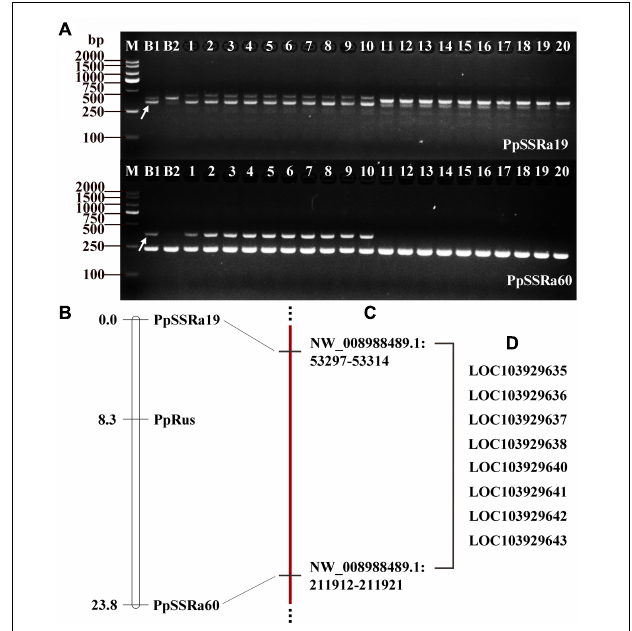
FIGURE 3 | Simple sequence repeat (SSR) markers and genetic linkage mapping of the PpRus locus. (A) Two SSR markers co-segregate with PpRus. M: DNA size marker DL2000; B1: non-russet skin fruit bulk; B2: russet skin fruit bulk; 1–10: non-russet skin individuals; 11–20: russet skin individuals. The polymorphic DNA fragments are indicated by arrows. (B) Genetic linkage map around the PpRus locus created from a segregating F 1 progeny population of 150 plants from the cross between ‘Niitaka’ (russet skin pear cultivar) and ‘Dangshansu’ (non-russet skin pear cultivar). (C) The physical positions of SSR marker loci linked to the PpRus locus in the pear genome. (D) The eight predicted genes within the region flanked by the two marker loci that are the most tightly linked to PpRus